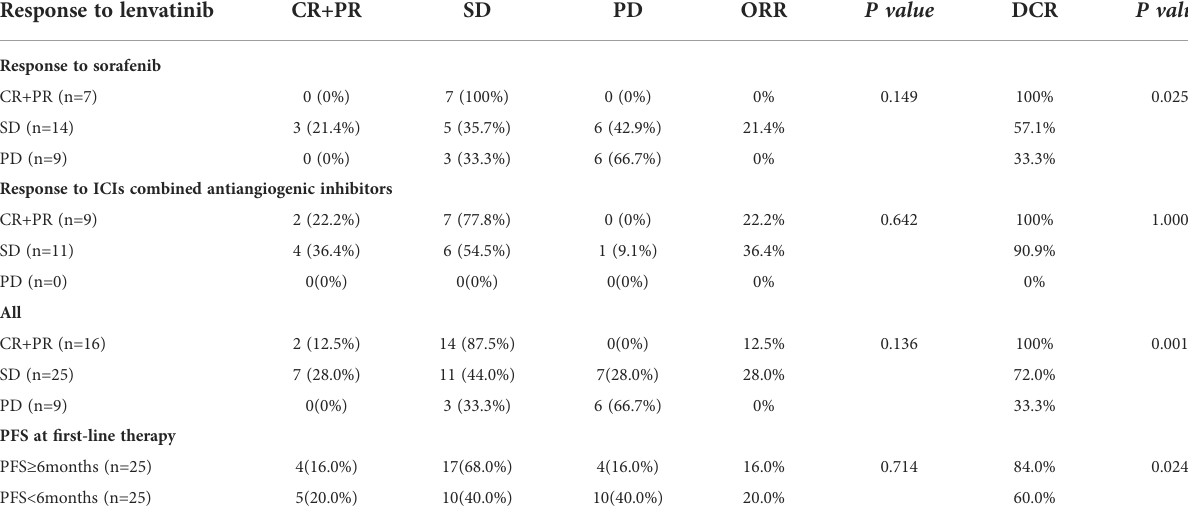
TABLE 3 The association between the ef fi cacy of fi rst-line treatment and lenvatinib. Response to lenvatinib